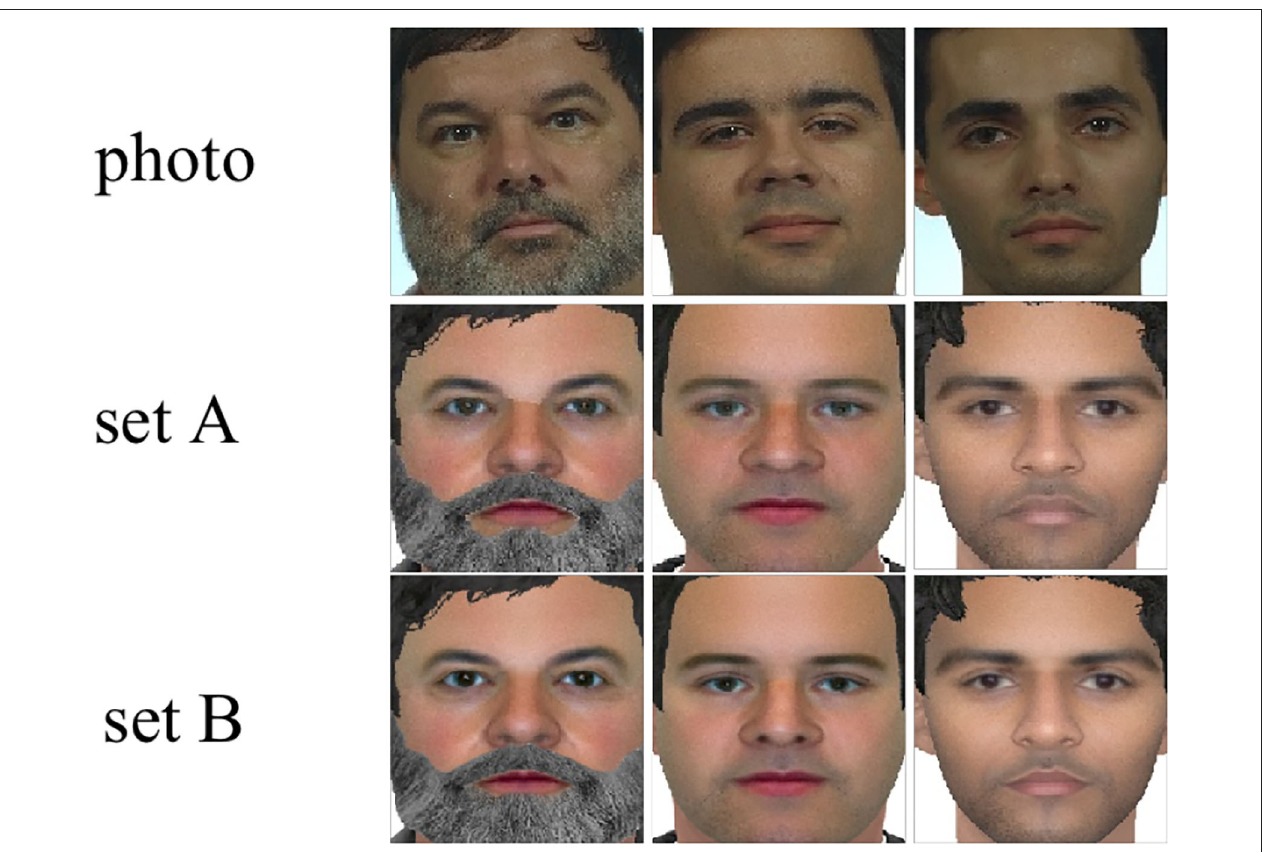
FIGURE 3 | Examples of cropped images from the UoM-SGFSv2 dataset, the top, middle, and bottom row are photo images, sketch images from set A and set B, respectively.